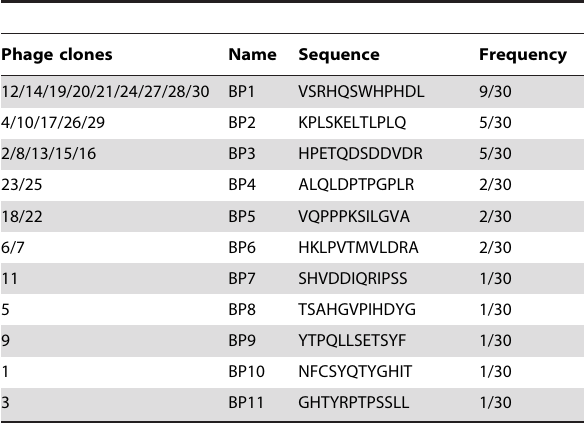
Table 2. The Amino Acid Sequences of 12 mer Peptides Screened from the Phage